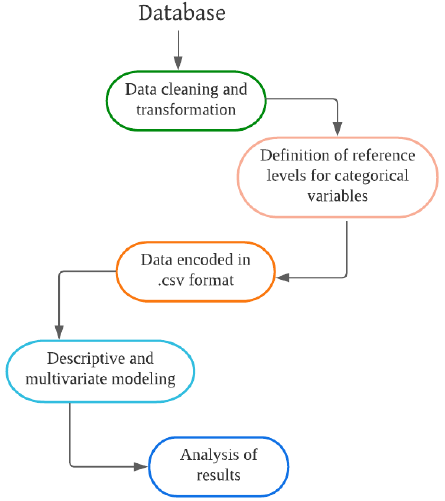
Figure 4. Data processing and multivariate presentation.